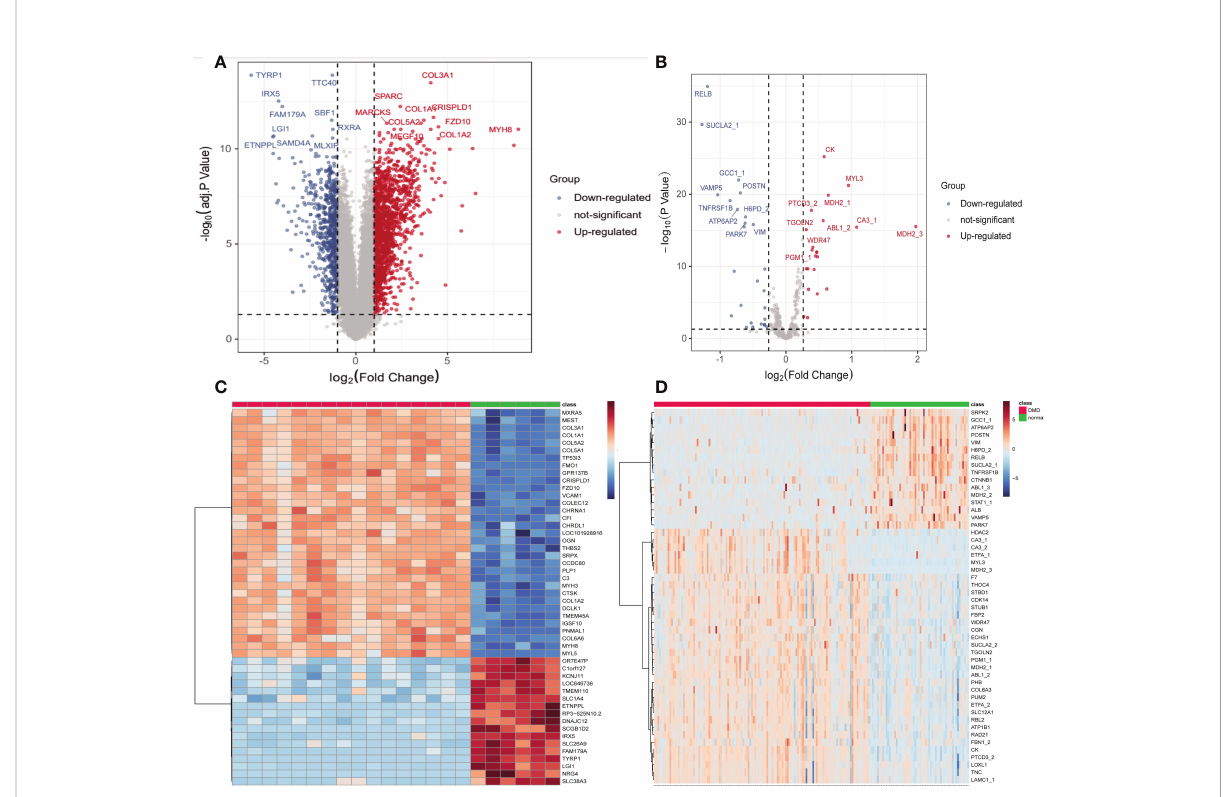
FIGURE 2 Identi fi cation of differentially expressed mRNAs (DEMs) and proteins (DEPs) in DMD. Volcano plots of DEMs in the GSE38417 (A) and DEPs in the E-MTAB-2564 (B) datasets. Heatmaps of the top 50 DEMs in the GSE38417 (C) and DEPs in the E-MTAB-2564 (D) datasets. Red, up-regulated DEMs/DEPs; blue, down-regulated